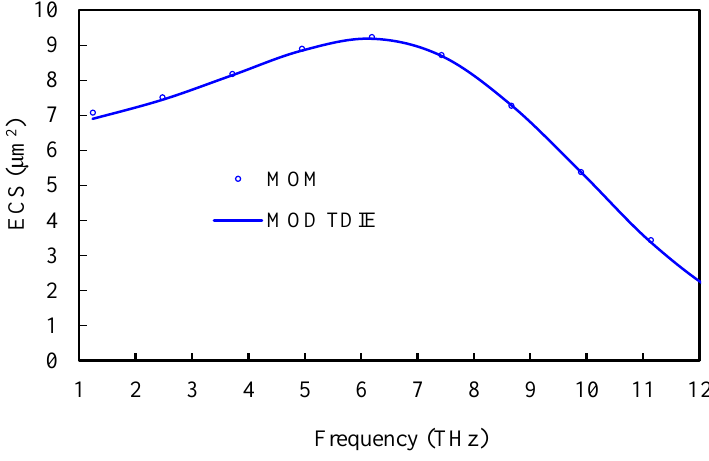
Figure 5. The extinction cross section (ECS) of the graphene sheet above 1 THz.